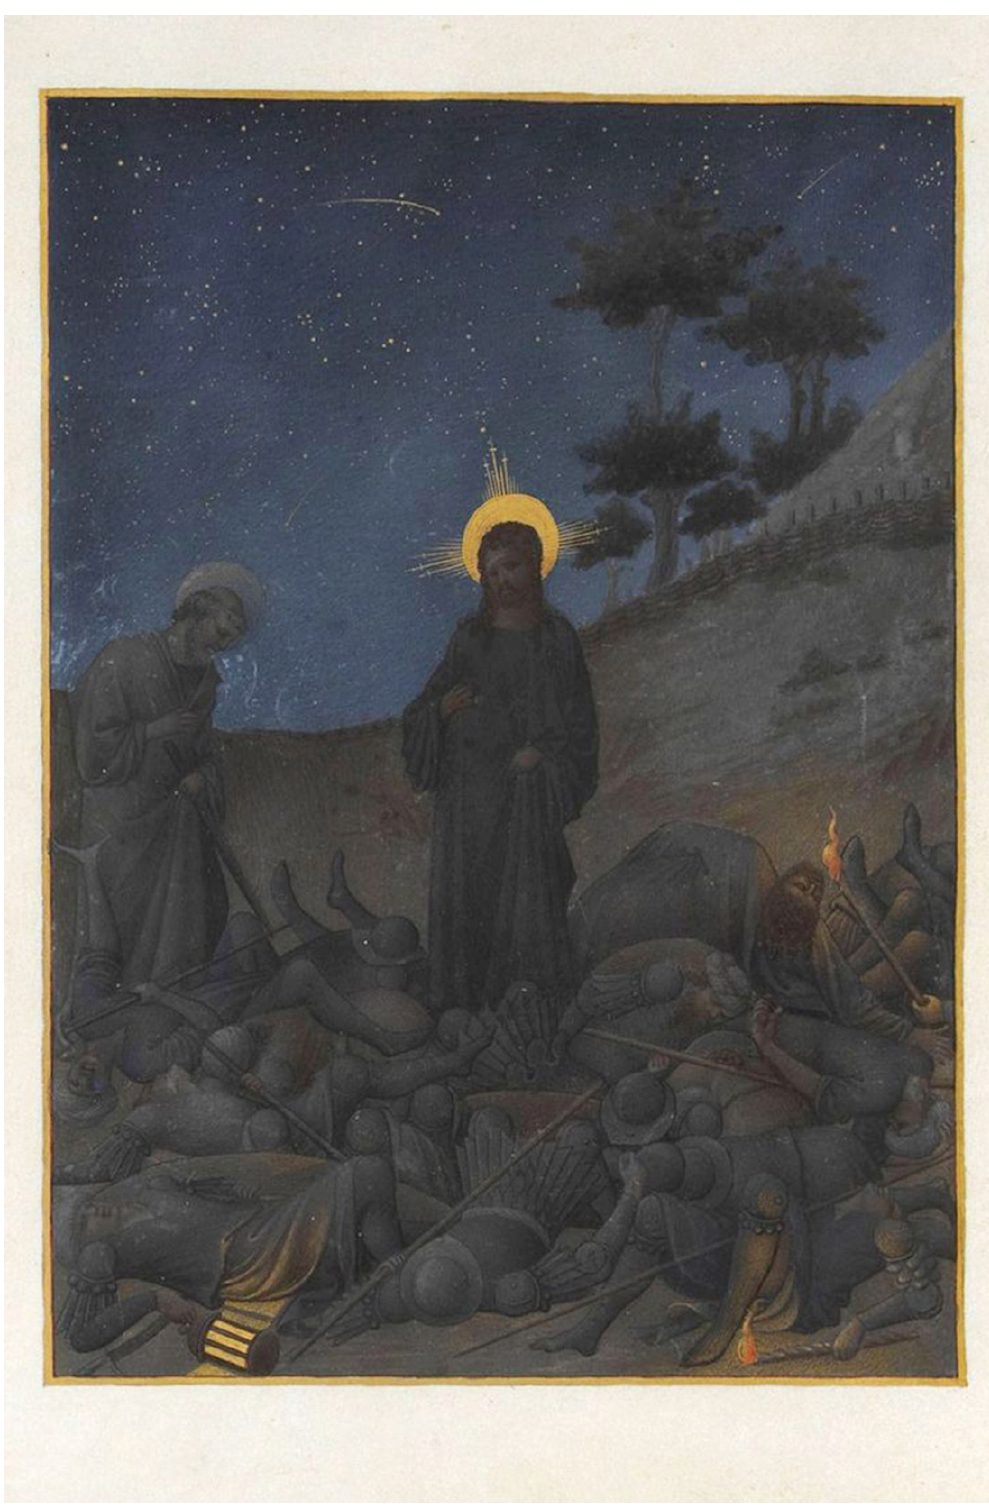
Figure 15. Arrest of Christ , from the Très riches heures de Jean, duc de Berri (before 1416). By the Limbourg Brothers. Musée de Chantilly MS65, fol. 142v. Photograph from Wikimedia and flagged for Limbourg Brothers. Mus é e de Chantilly MS65, fol. 142v. Photograph from Wikimedia and flagged for noncommercial use. noncommercial